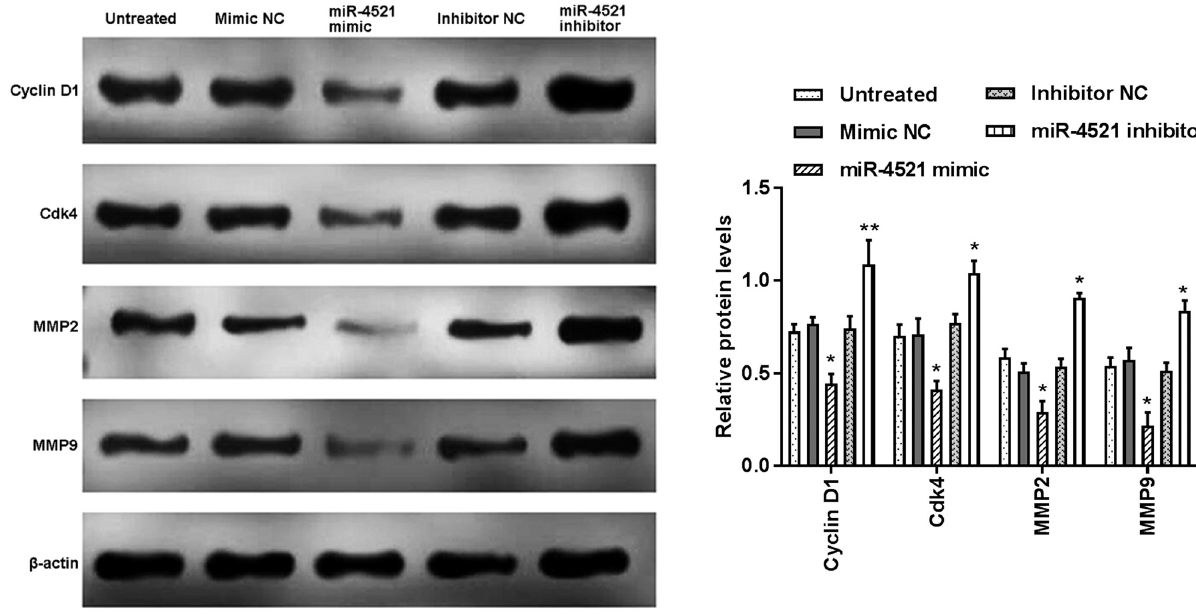
Figure 5: Cell proliferation - , migration - , and invasion - related protein levels were measured by western blot analysis. Enhanced miR - 4521 expression inhibited the cyclin D1, Cdk4, MMP2, and MMP9 levels ( * P < 0.05 ) .